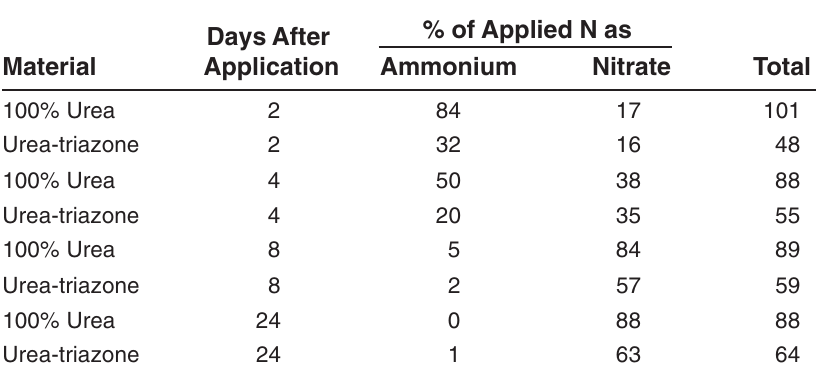
Mineralization of Urea and